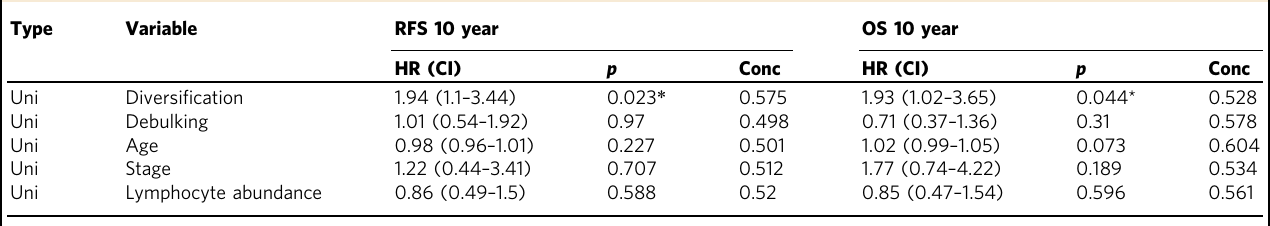
Table 2 Prognostic value of morphological diversi fi cation in the Immunoreactive subtype Type